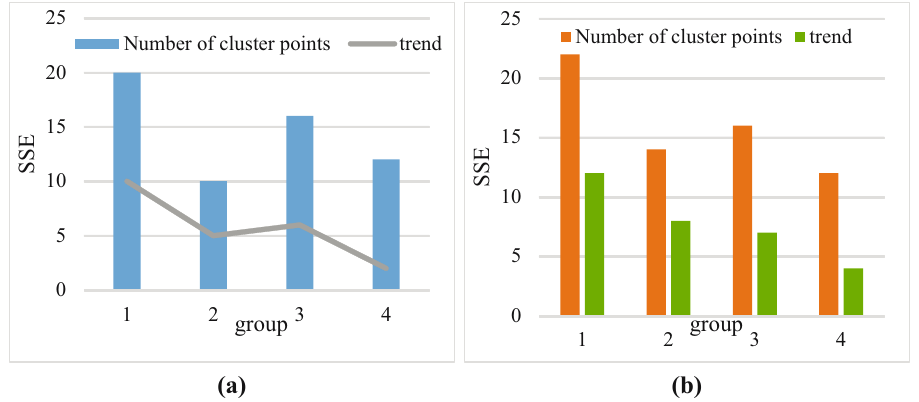
Figure 5: Results of the 1st and 2nd clustering experiments: ( a ) the fi rst clustering data and ( b ) the second clustering data.